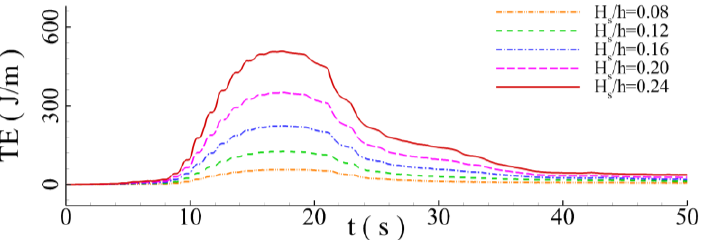
Figure 22. Comparisons of the total water wave energy in the whole computational domain under different relative significant wave heights.